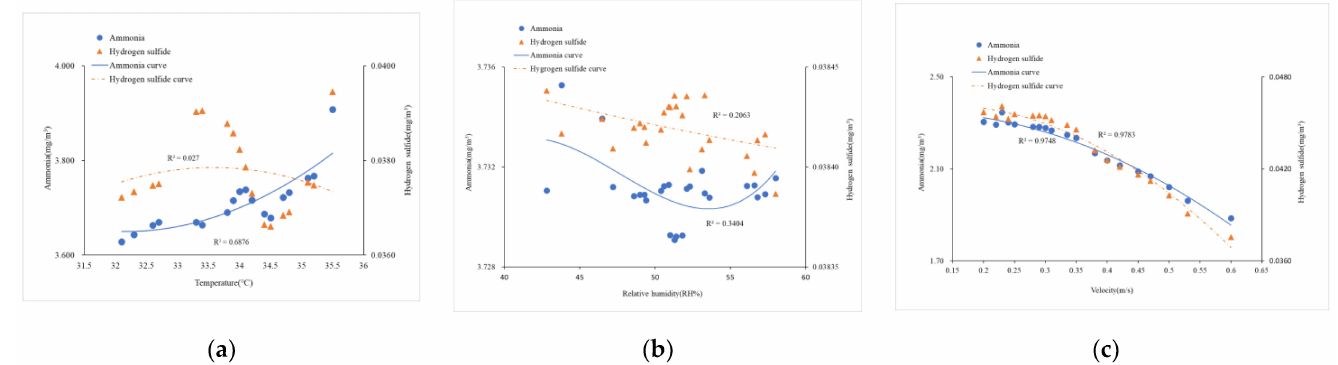
Figure 9. ( a ) Regression analysis of pollutant concentration with indoor air temperature; ( b ) regres- sion analysis of pollutant concentration with relative humidity; ( c ) regression analysis of pollutant concentration with airflow.